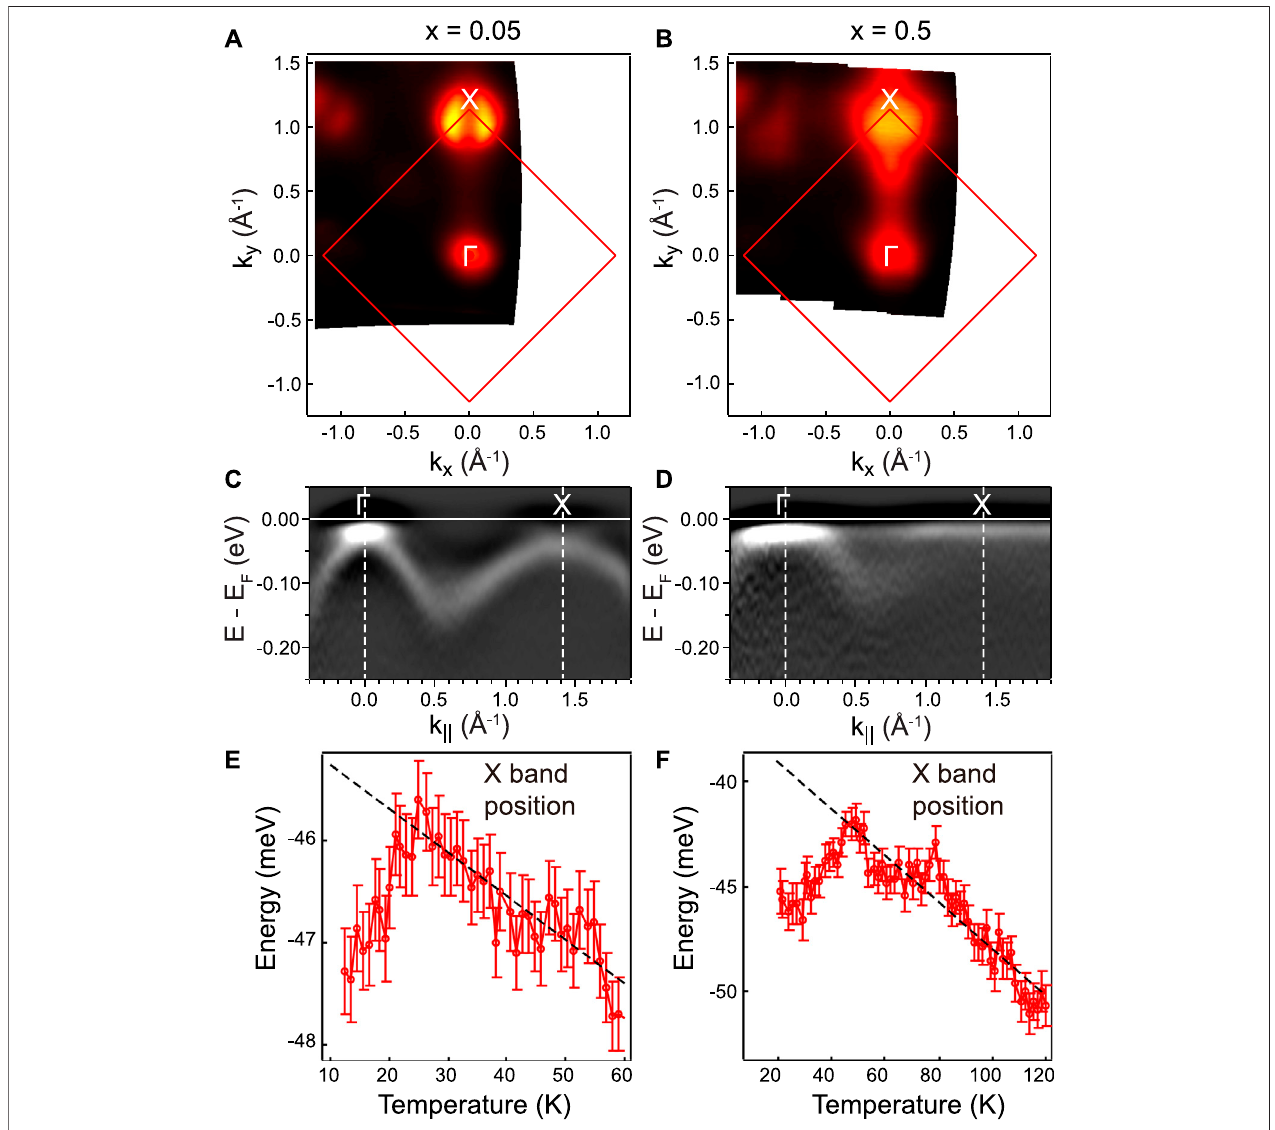
FIGURE 4| (Color online) ARPES results on x = 0.05 (left) and x = 0.5 (right) compounds. (A) – (B) The measured Fermi surfaces around the Γ and X points. (C) – (D) Banddispersionsalongthehighsymmetrydirection Γ - X obtainedfromthesecondderivativesintheenergydirection. (E) – (F) Temperaturedependenceofthe fi ttedband position from the X point. All dashed lines are guides for